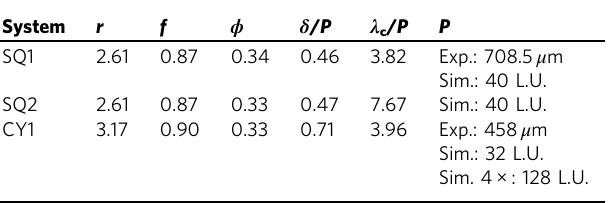
Table 4 Surface geometry and liquid parameters used in experiments and simulations.